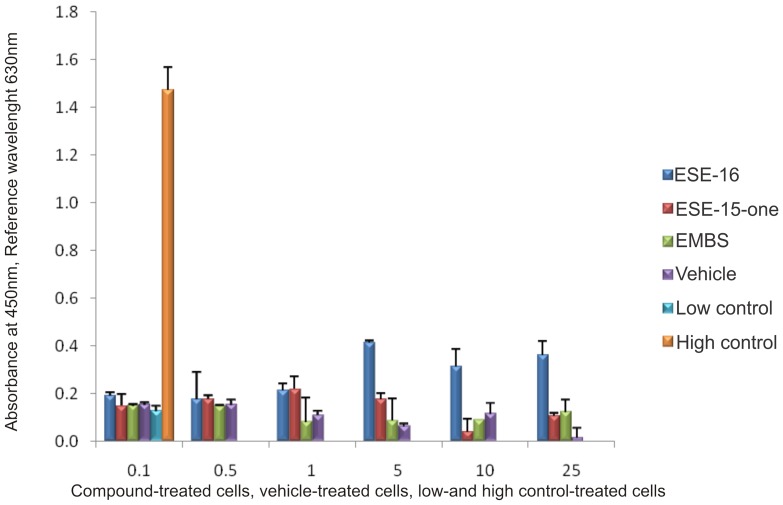
Cytotoxicity by means of lactate dehydrogenase assay.LDH levels of ESE-15-one, EMBS and ESE-16 -treated HeLa cells and vehicle-treated control cells after 24 h exposure. The background control consists of growth medium only. The low control refers to cells resuspended in growth medium and the high control to cells resuspended in growth medium with cell lysis solution added to the cells shortly before the experiment was terminated (according to the manufacturer's instructions). No statistically significant increase in LDH levels was observed in treated cells. These results showed that the sulphamoylated compounds were not toxic to the cells.